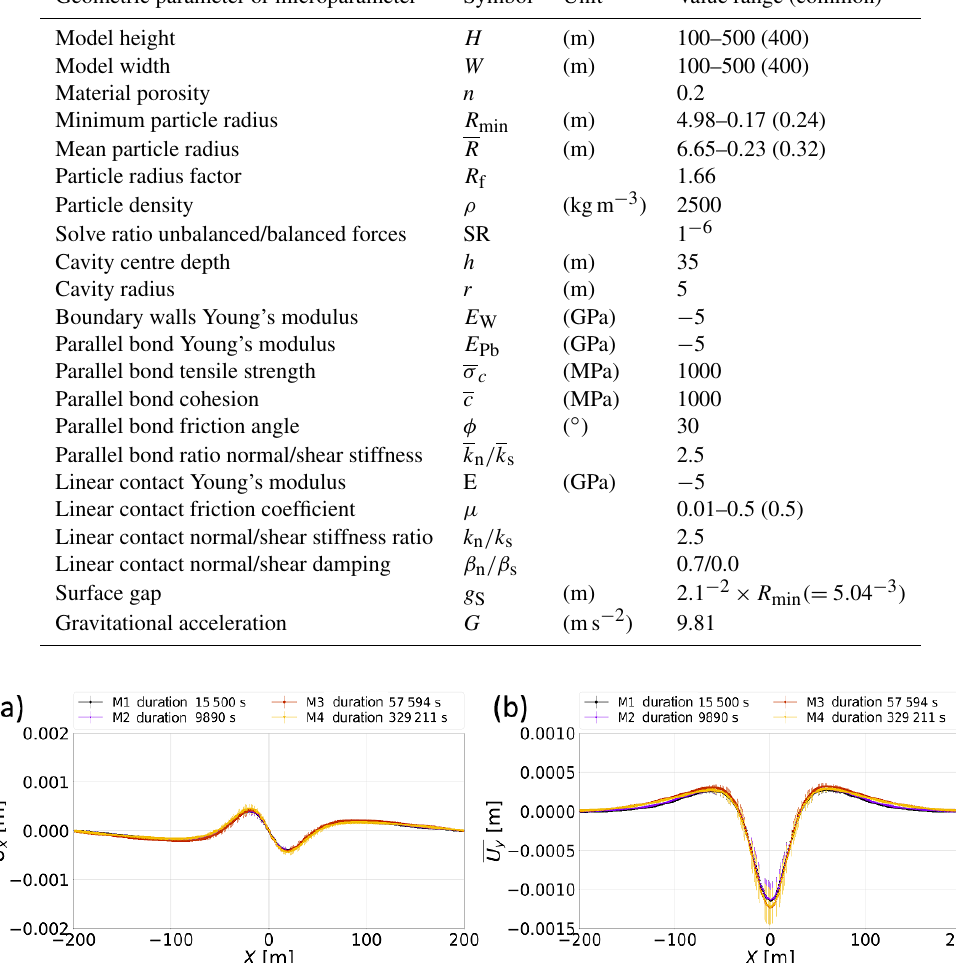
Figure B1. Displacement plots for different void installation methods. (a) Horizontal and (b) vertical model setup with size 400 × 400m using a coarse particle distribution (mean radius 0.74m). Indication of needed simulation time is given in the legend. M1–M4 refer to the installation methods described in the